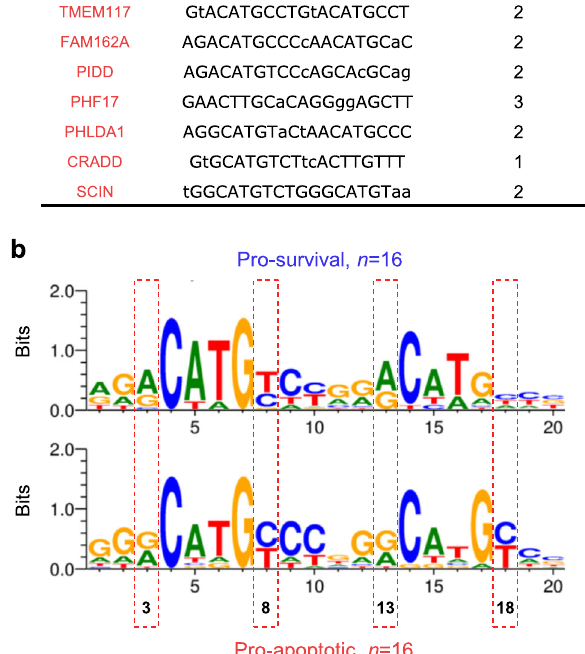
these arginine residues convert to predominantly non-polar,